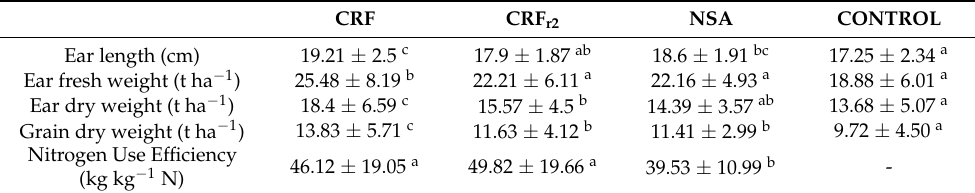
Table 4. Field harvest comparison of growth parameters and grain yield of Zea mays var.